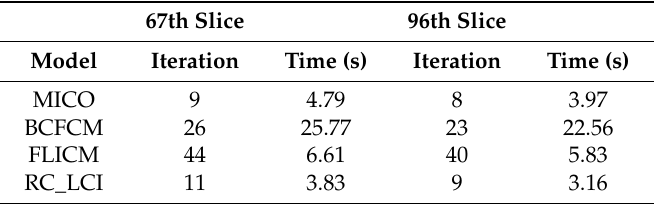
Table 1. The iterations and CPU time of MICO, BCFCM, FLICM, and RC_LCI.